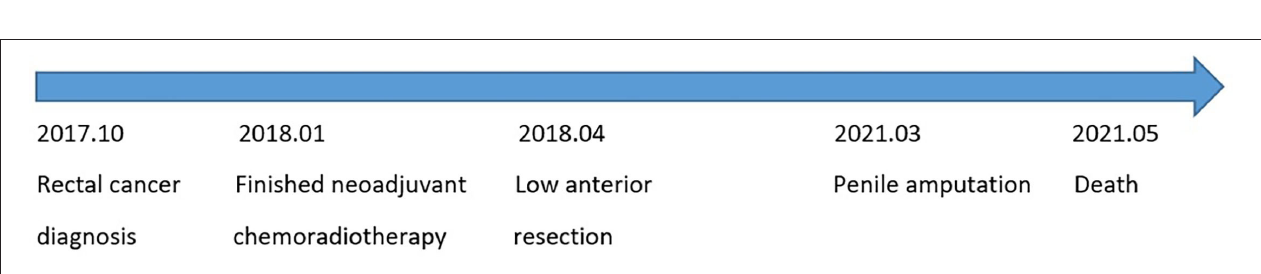
FIGURE 6 | Timeline of the presented